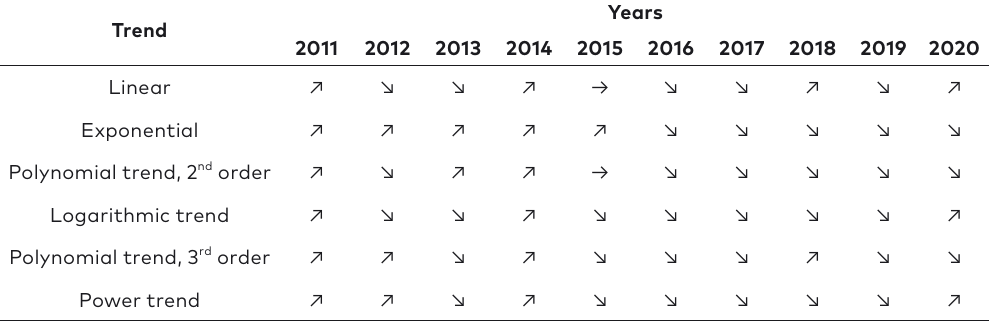
Table 4. General evaluation for all